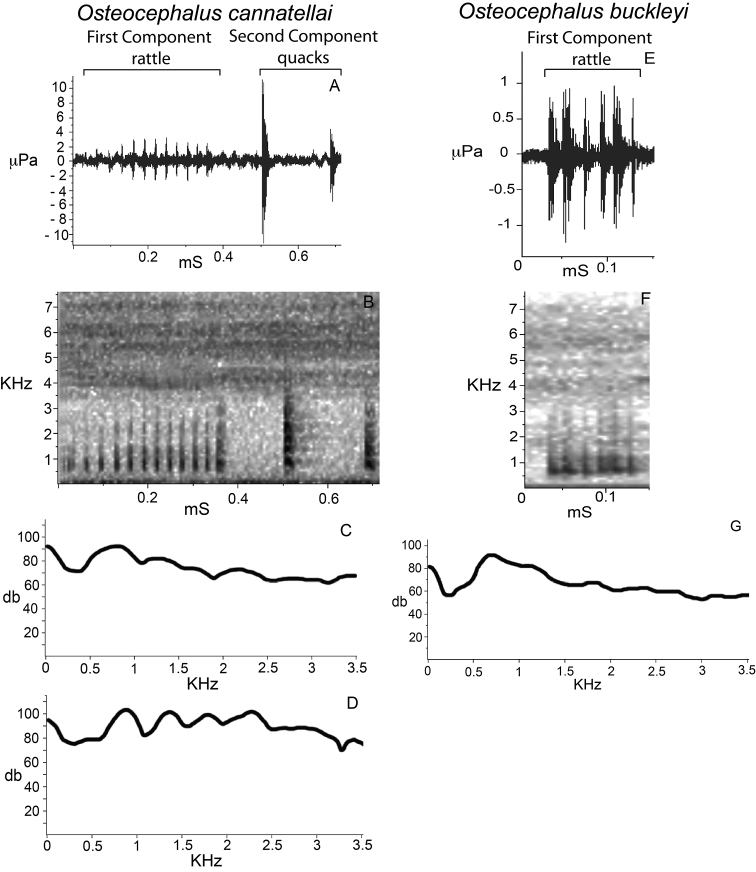
Advertisement calls of Osteocephalus. A–D
Osteocephalus cannatellai (QCAZ8322) from Río Piraña, Provincia Orellana, Ecuador; E–G
Osteocephalus buckleyi, from Jatun Sacha, Provincia Napo, Ecuador. A and E are oscillograms, B and F spectrograms, C and G power spectra of complete call, and D power spectra of quacks (second component).